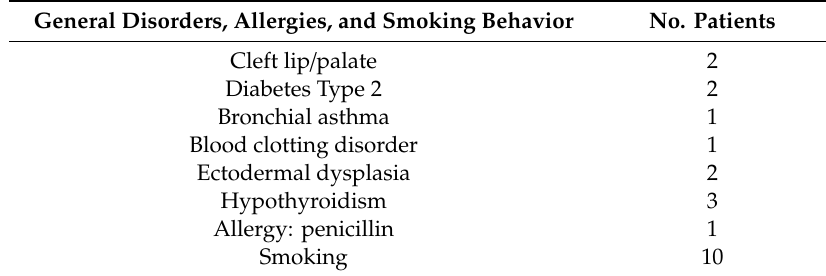
Table 2. Patients’ medical condition, allergies, and smoking behavior recorded prior to treatment. General Disorders, Allergies, and Smoking